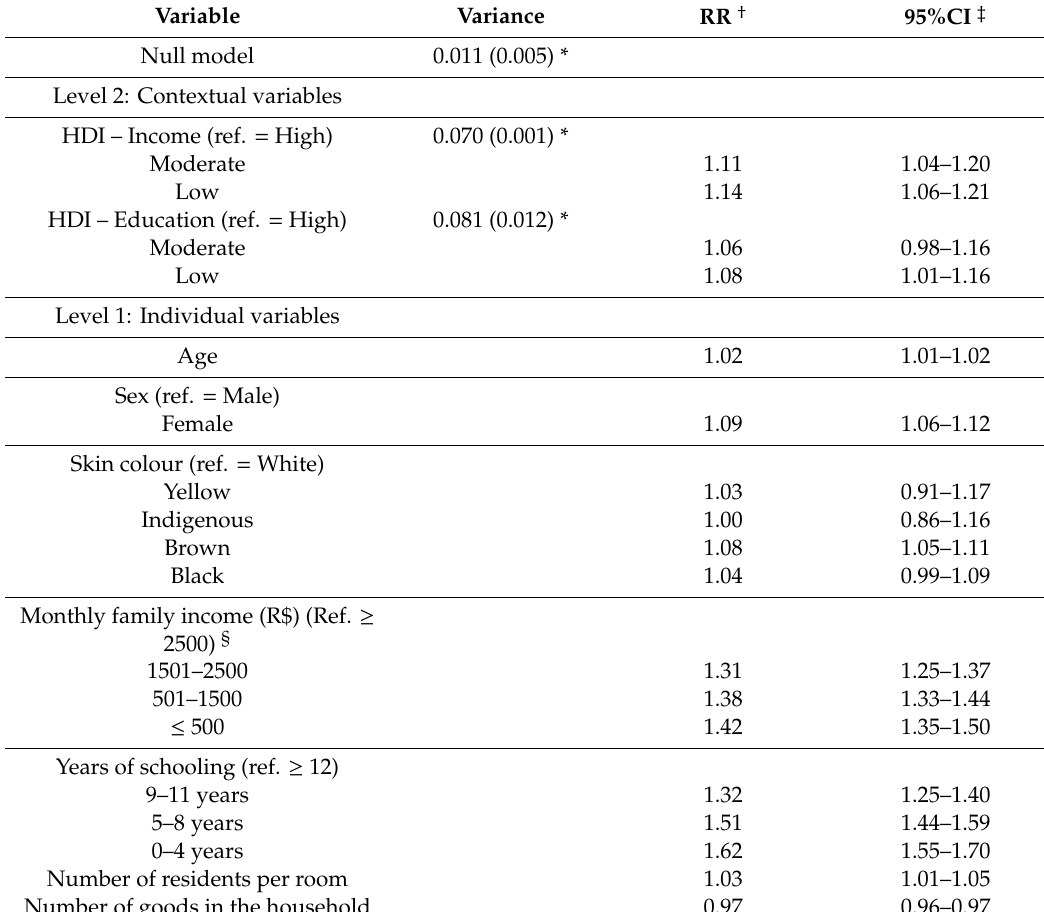
Table 2. Crude associations of contextual factors and individual characteristics with tooth loss among elderly people determined by multilevel negative binomial